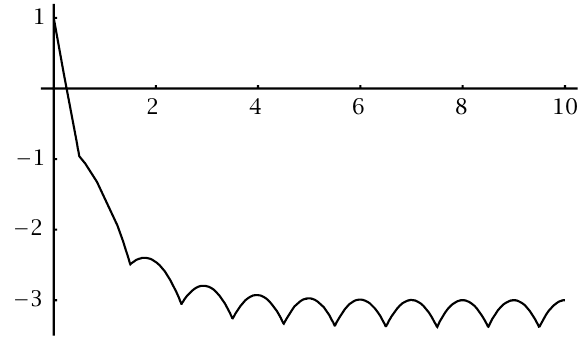
Figure 7.1 . T j (t) for b(t) = be st , b = 0 . 75, s = d j = 1, j = 1, a = 1 /π